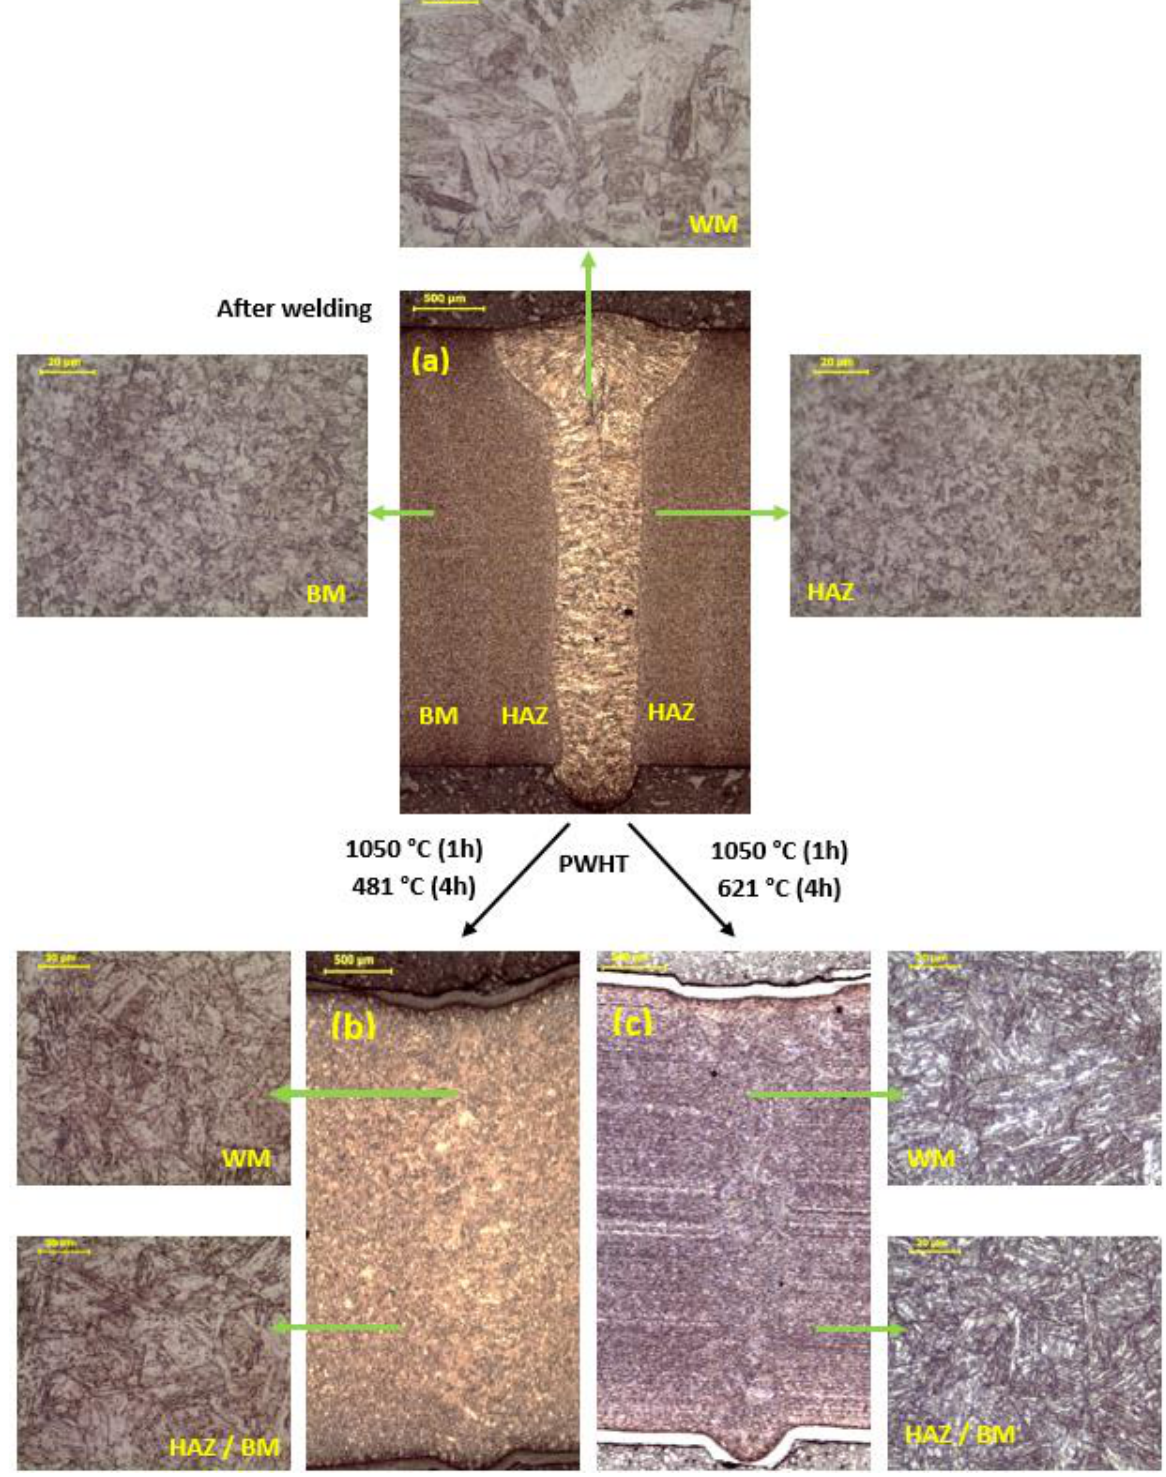
Figure 3. The microstructure of the joint after: ( a ) welding, ( b ) PWHT (1050 °C/481 °C), and ( c ) PWHT (1050 °C/621 °C). ( c ) PWHT (1050 ◦ C/621 ◦